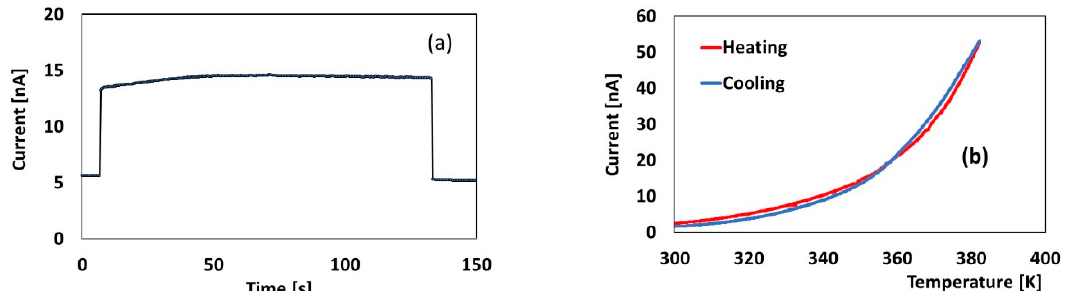
Figure 6. ( a ) Photoconductivity measured during the priming process on a single crystal CsPbBr 3 sample illuminated with a 400 nm LED at T i = 290 K, V b = 2 V; ( b ) TSC cycle (heating and cooling) measurement carried out after priming, showing the absence of thermally stimulated peaks.